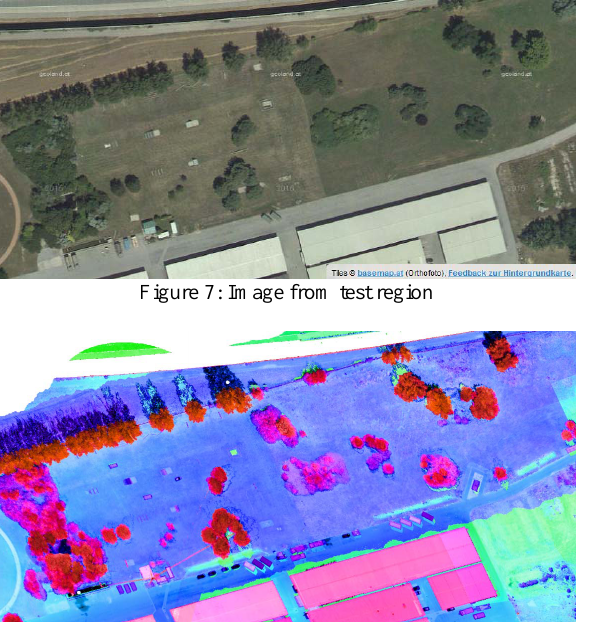
Figure 8: Laserscan data color-coded with height and reflectivity as color brightness.